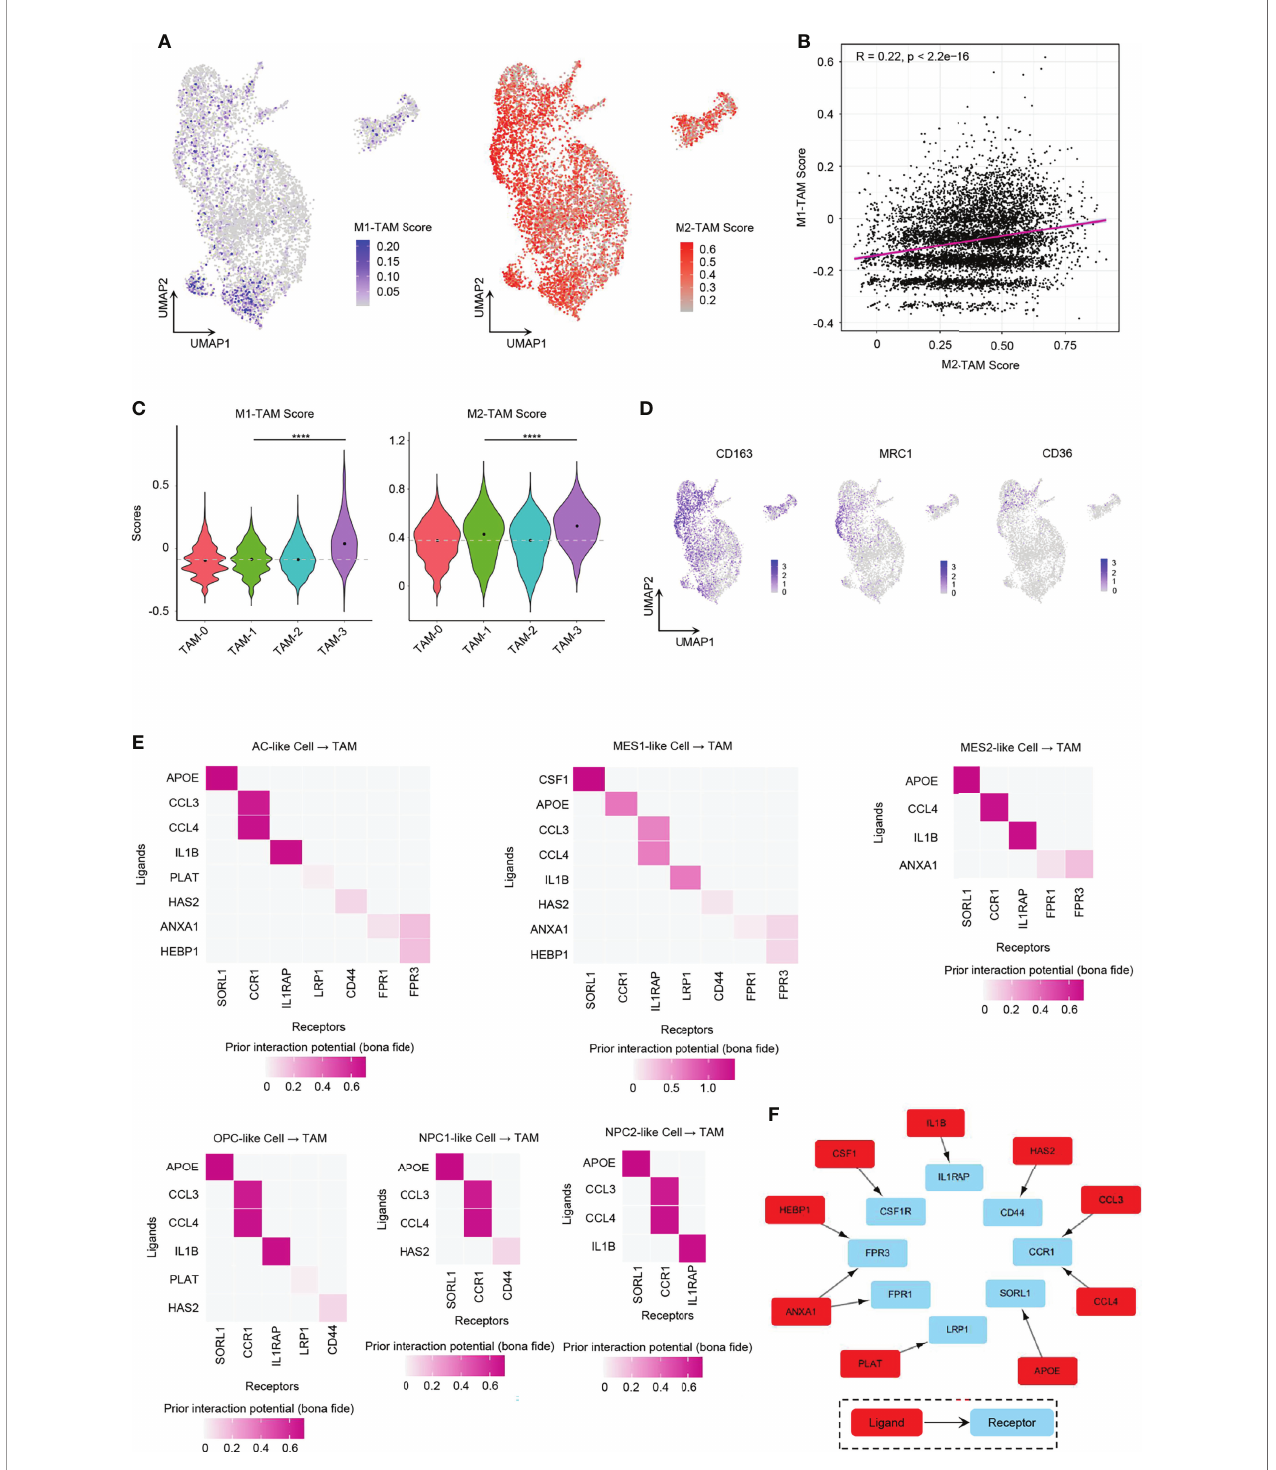
FIGURE 7 | Role of GBM tumor cells in promoting TAM M2-type polarization. (A) UMAP projection showed the M1-TAM score and M2-TAM score in TAMs. (B) Correlation between M1-TAM score and M2-TAM score in TAMs. (C) Violin plot of the M1-TAM score and M2-TAM score in different TAM clusters. (D) Expression levels of M2-TAM marker genes, namely, CD163 , MRC1 , and CD36 , in TAMs. (E) Ligand – receptor pairs from different GBM tumor cellular state cells to TAMs took part in TAM M2-type polarization. (F) Ten L – R pairs, in total, could promote TAM M2-type polarization. Gray dash line, average score; **** p < 0.0001. See also Supplementary Figure 8